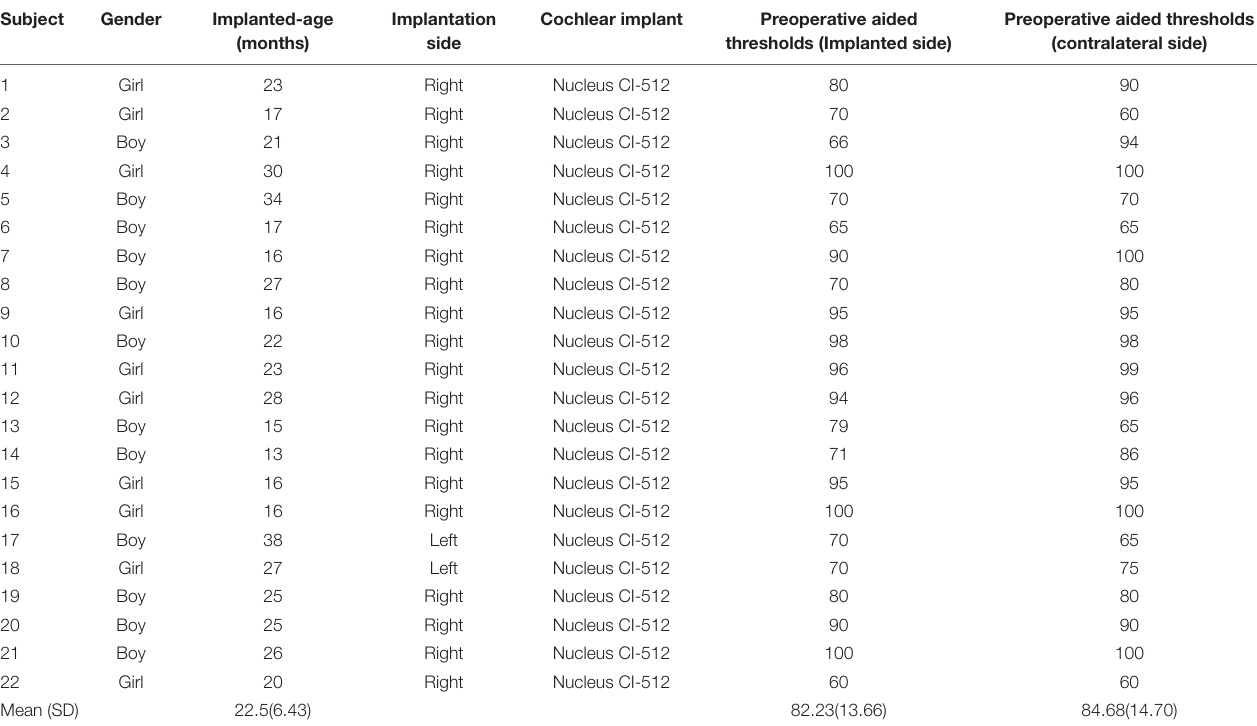
TABLE 1 | Demographic and clinical information of